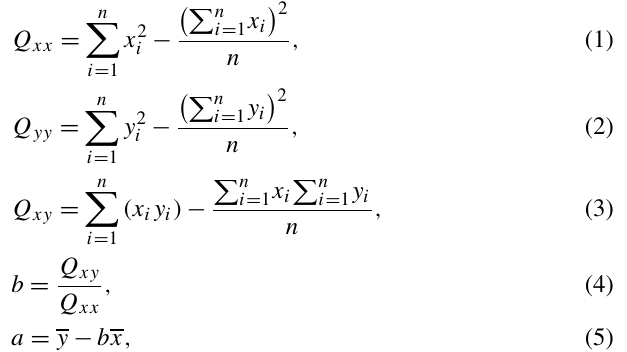
ment (Fig. S16). The linearity test was performed through a double injection of 11 standards with evenly distributed con- centrations over 1 order of magnitude, for which the maxi- mum concentration corresponded to standard 3 in Table